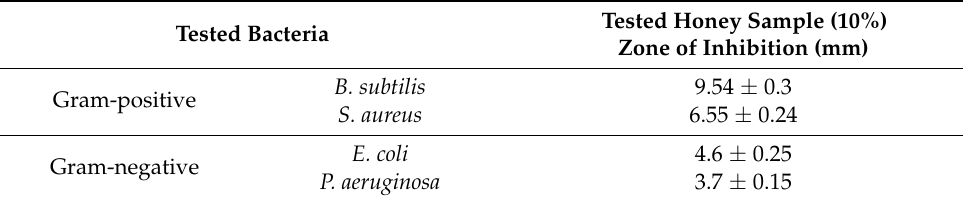
Table 3. Zone of inhibition of various bacterial isolates treated with manuka honey. Tested